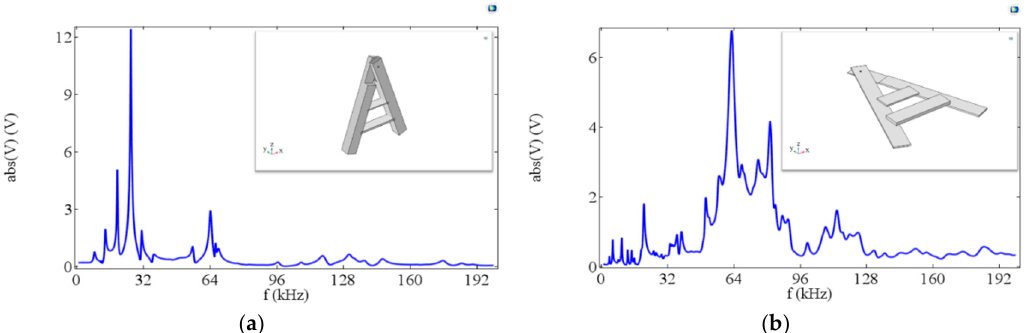
Figure 15. The relationship between the output voltage and frequency for A-line shape ME structures with ( a ) ABS trestles and with ( b ) mica trestles.